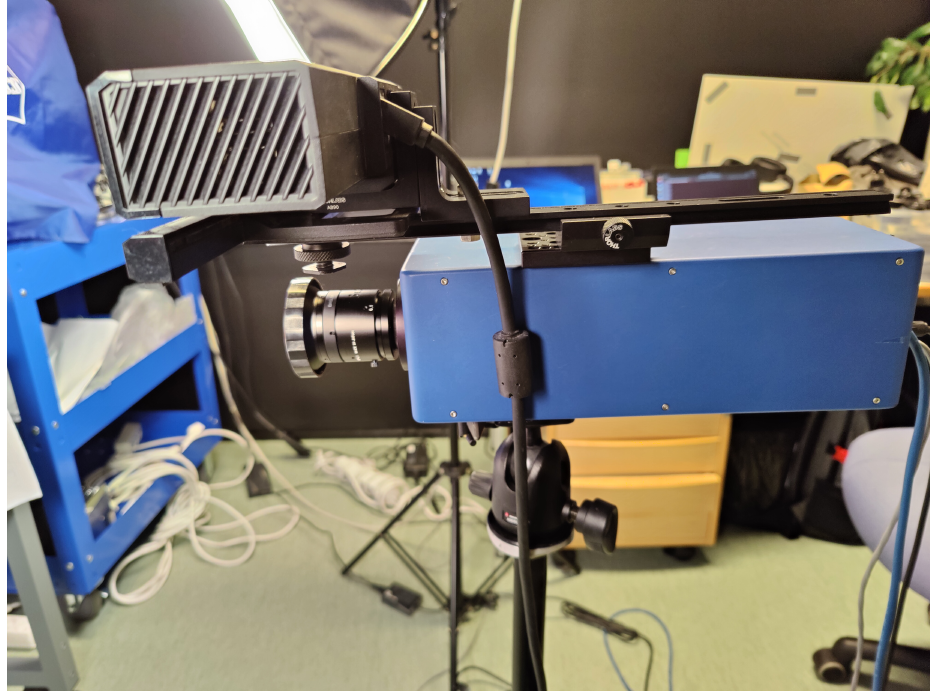
Figure 1. The prototype FPI hyperspectral camera ( below ) and the Kinect ( on top ) used in the